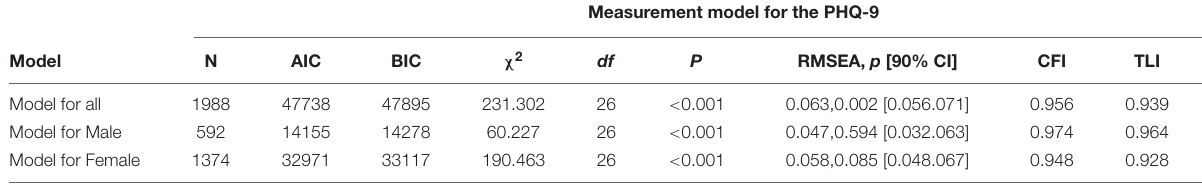
TABLE 1 | Measurement models.